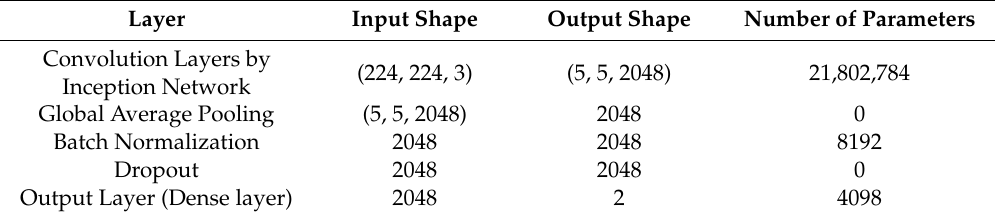
Table 3. Inception-based CNN architecture used in our